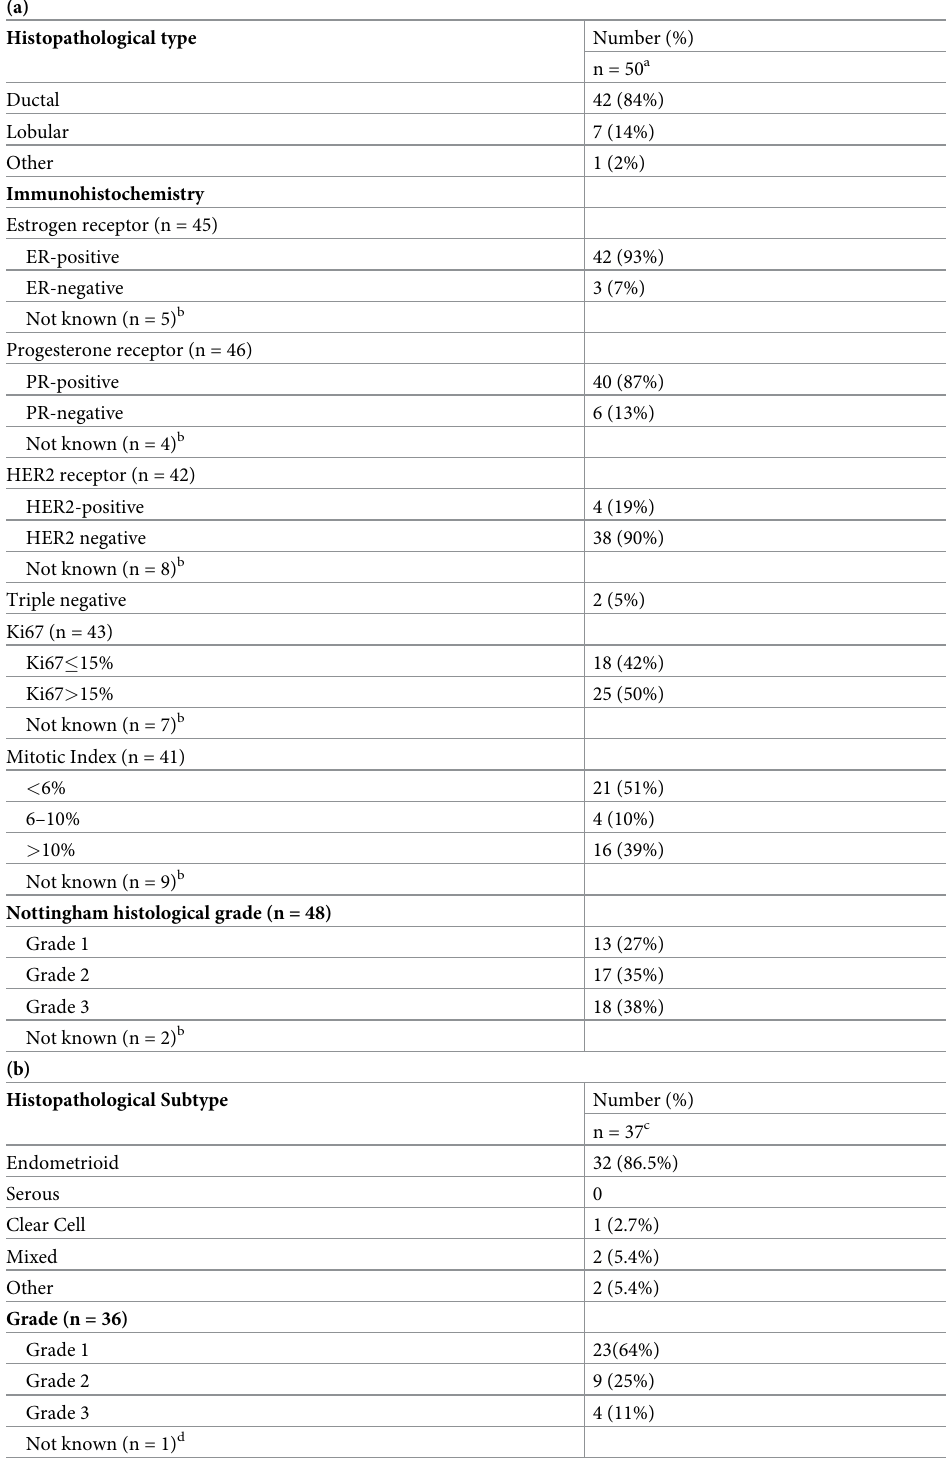
Table 2. (a) Histopathological data for breast cancer patients. (b) Histopathological data for endometrial cancer patients.